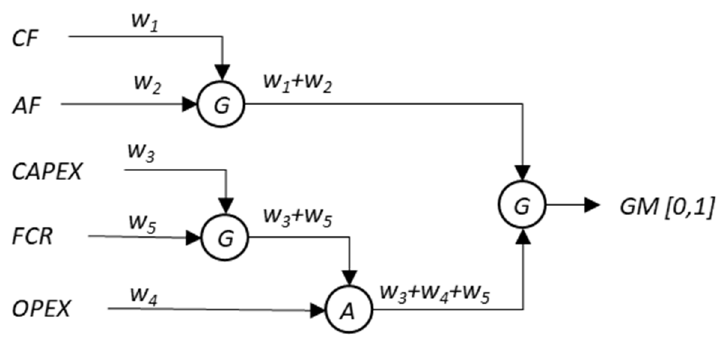
Figure 6. Aggregation of MOE.